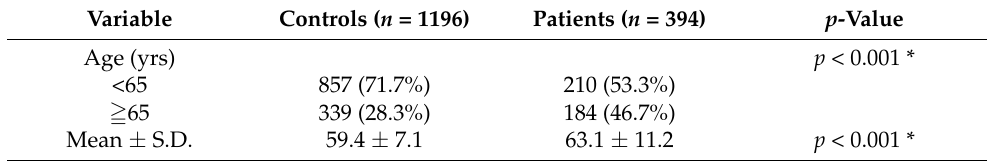
Table 1. The distributions of age in 1196 controls and 394 patients with hepatocellular carcinoma (HCC).